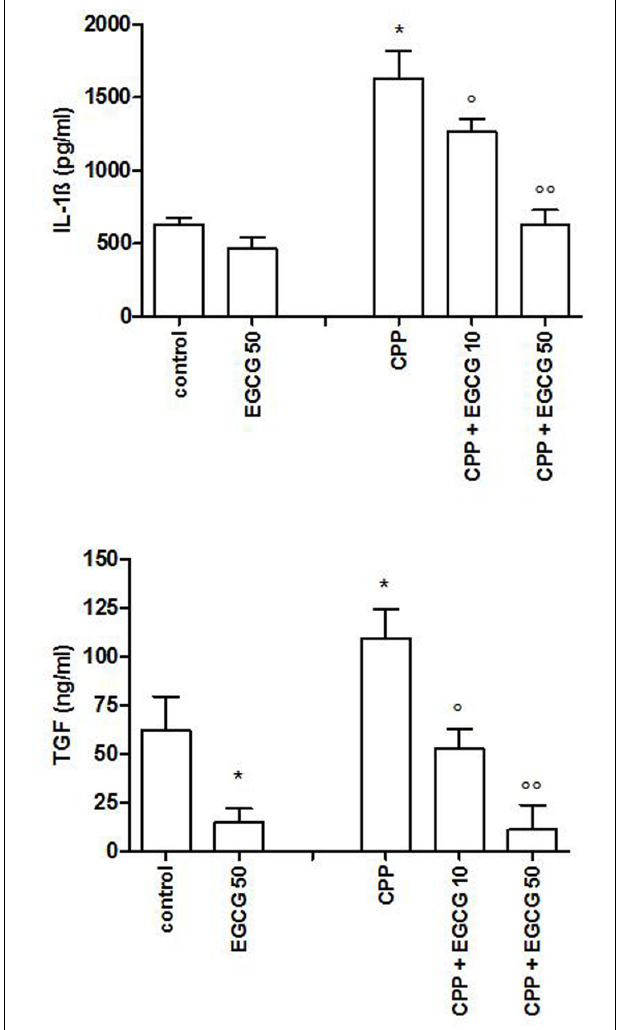
FIGURE 3 | IL-1 β andTGF β levels after a pretreatment of 3 h ofTHP-1 cells with PMA and stimulation with CPP crystals. The values are expressed as the mean ± SD; CPP 0.025 mg/ml; PMA 300 ng/ml; EGCG expressed as micromolar. Data are representative of one of three independent experiments ± SD of three replicates. * p < 0.05 vs control; ◦ p < 0.05, ◦◦ p < 0.01 vs